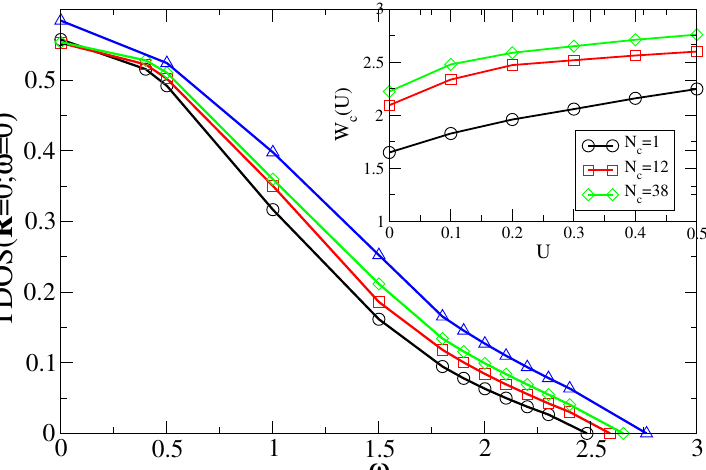
Figure 41. Screening of disorder effects by weak interactions in the 3D Anderson-Hubbard model: The main panel shows the momentum integrated typical DOS, TDOS( R = 0; ω = 0) for N c = 38 as a function of disorder, W for various U values (units 4 t = 1). The inset shows that the critical disorder value, W c ( U ) increases with increasing U for three cluster